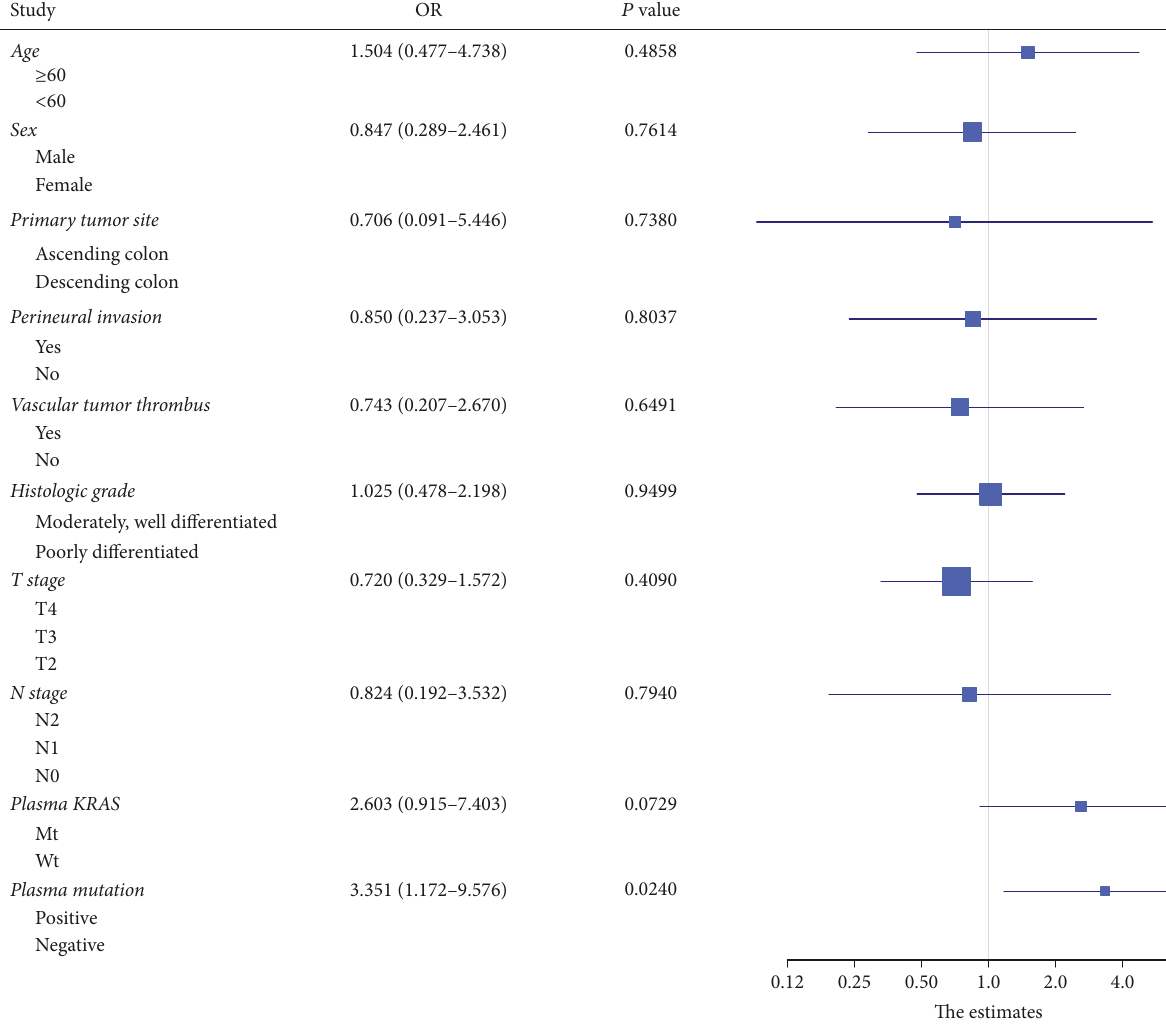
Supplement Table 1: patients underwent a radical surgery with measurable DFS. 40 patients who underwent a radical surgery had measurable DFS, used to explore any factors that might influence DFS. Supplement Table 2: patients treatment in subsequent first-line chemotherapy with measurable